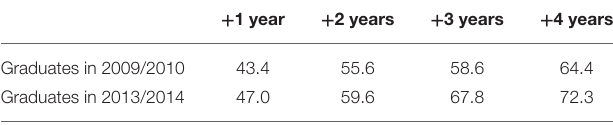
TABLE 7 | University graduates’ employment rate in the 4 years after graduation.